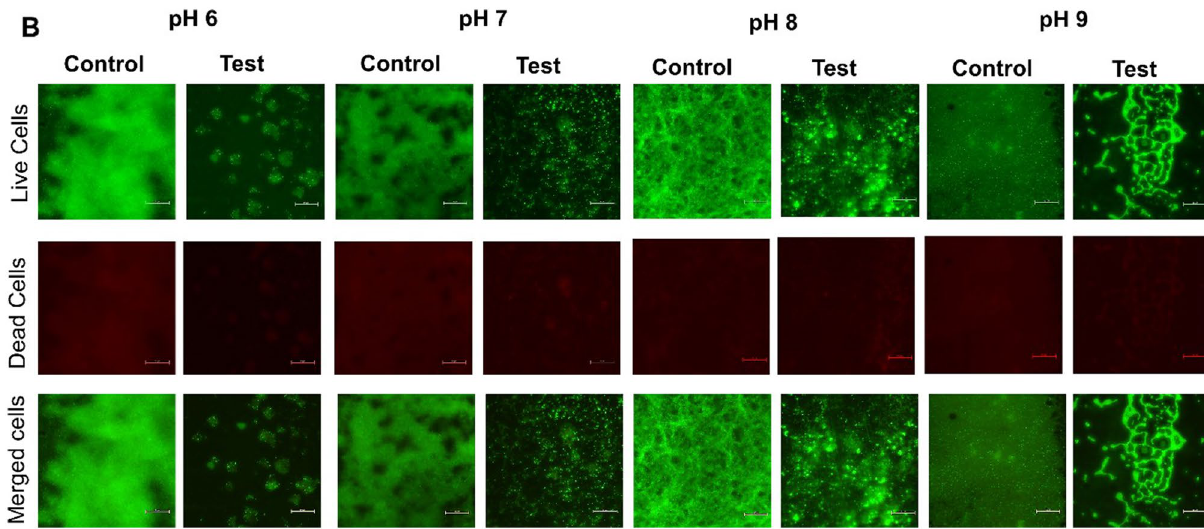
Figure 10. Fluorescent microscopy images of the biofilm formed by V. cholerae HYR14 in the CAP-2M4VP treated (Test) and untreated (Control) conditions incubated statically for 24 h at 37 °C. At pH 6, pH 7, pH 8 and pH 9, the biofilms formed by V. cholerae HYR14 upon treated with 31.25 μg/mL of CAP-2M4VP nano- formulation was minimal compared to the biofilm formed at the untreated (control)